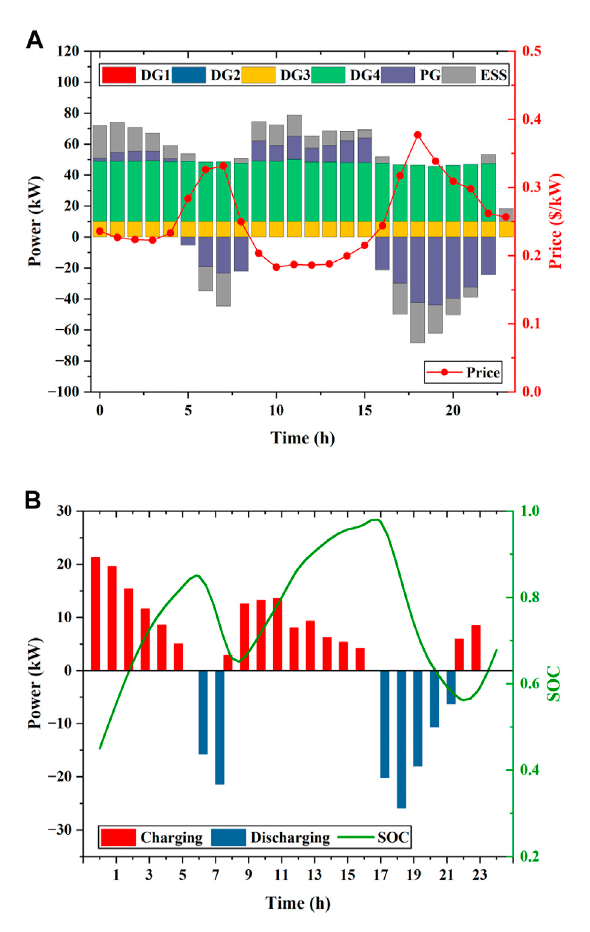
FIGURE 9 SchedulingresultsoftheMGobtainedbytheproposedapproach with an initial value of 0.45 for the SOC: (A) Generation schedules of DGs, ESSs, and the main grid; (B) scheduled charging or discharging power and